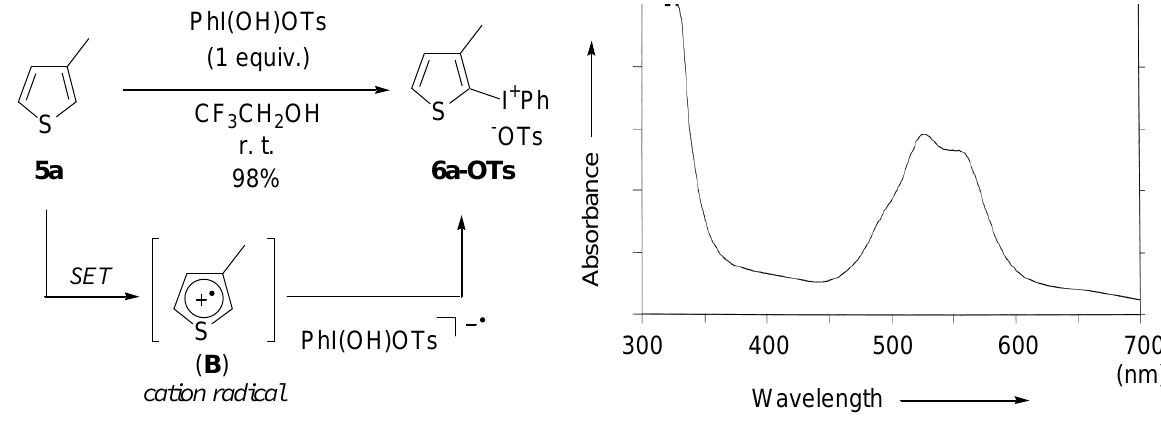
Figure 3. UV-VIS spectrum of the reaction of 3-methylthiophene ( 5a ) using HTIB in CH OH. (The reaction was performed using an equimolar amount of thiophene 5a and CF 3 2 HTIB in CF CH OH (0.20M) at room 3 2